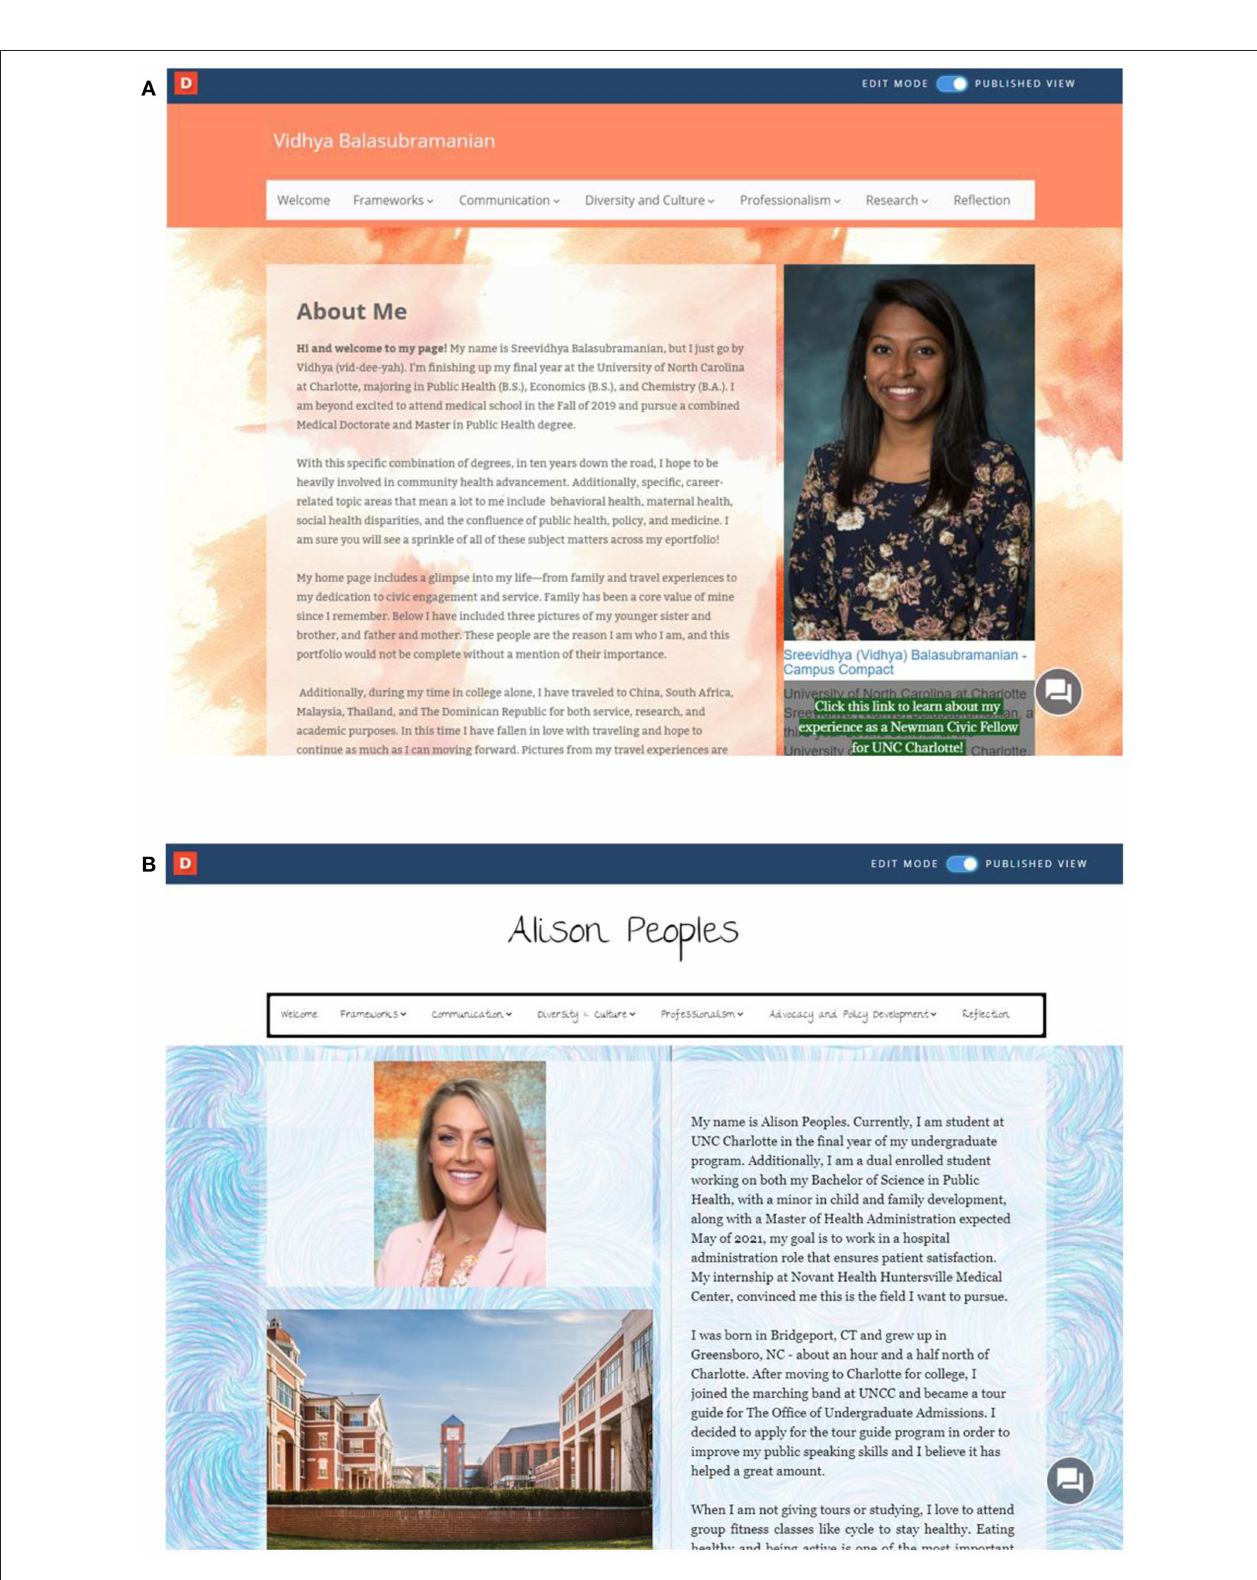
FIGURE 2 | Homepages for two BSPH student ePortfolios. (A) Homepage for Vidhya. Used with written informed consent of the student. (B) Homepage for Alison. Used with written informed consent of the student.